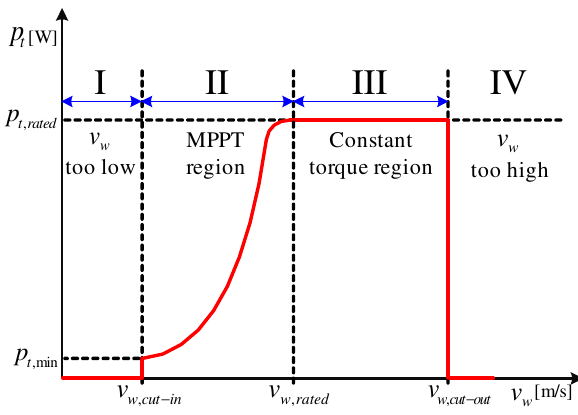
Figure 2. Regions of operation for modern variable-speed wind turbines.